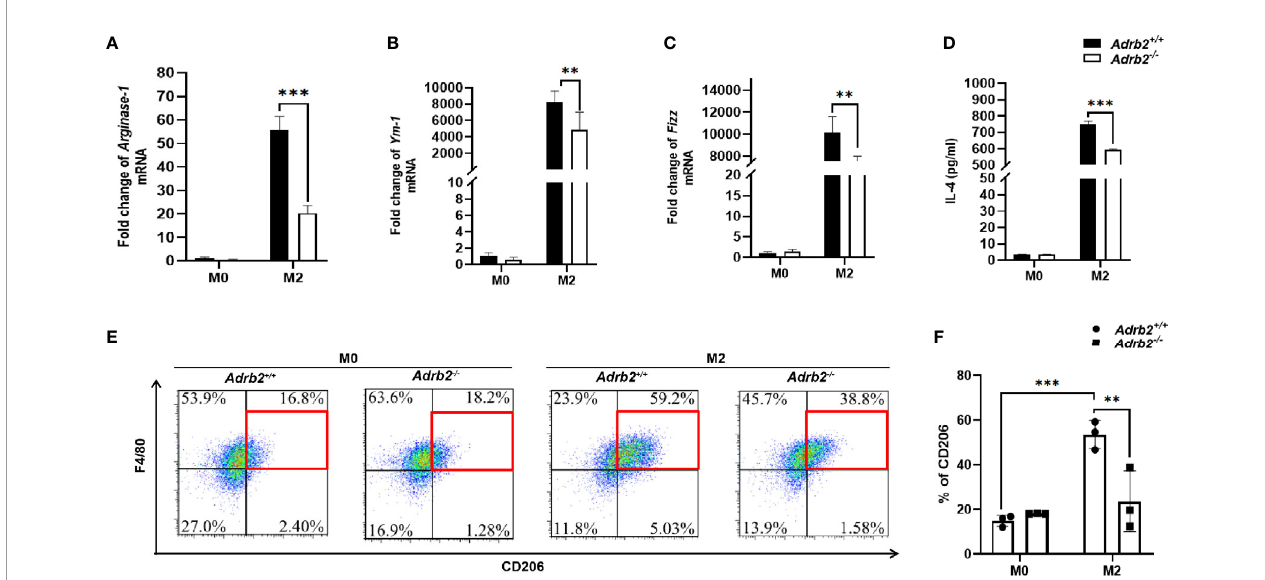
FIGURE 5 | b 2-AR enhances alternatively activated macrophages invitro . The experimental setup of the invitro model used bone marrow – derived macrophages (BMDM). BMDM was divided into two groups, M0 (unstimulated BMDM) and M2 or alternativelyactivatedmacrophages (IL-4 stimulated BMDM for 24 h). The concentration of recombinant IL-4 used to stimulate the BMDM was 20 ng/ml. Comparedto the unstimulatedmacrophages, the IL-4-stimulated macrophages showed a signi fi cant increase in M2 markers. (A – C) The mRNA levels of Arginase-1 , Ym-1 , and Fizz were increasedin alternativelyactivatedmacrophages. (D) ELISA ’ s resultshoweda signi fi cant increase in the production of IL-4 in alternatively activated macrophages. (E, F) The fl ow cytometry result showed a signi fi cant increase in the percentage of CD206 mannose receptors in alternatively activated macrophages. b 2-AR-de fi cient alternativelyactivatedmacrophages decreased the M2 markers such as IL-4, Arginase-1, Ym-1, Fizz, andCD206 compared to Adrb2 +/ + alternatively activated macrophages. Compared withindicated groups, ** P < 0.01, *** P <